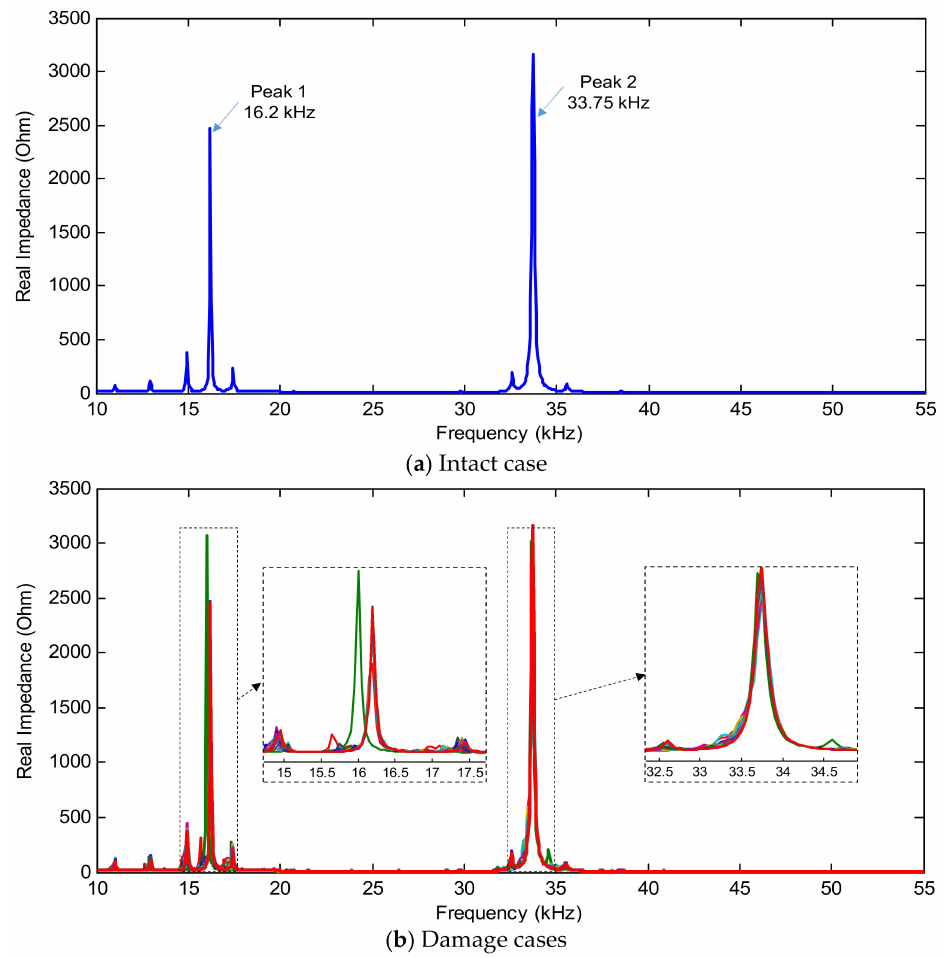
Figure 3. Numerical impedance signatures of PZT interface for intact and damage cases of plate